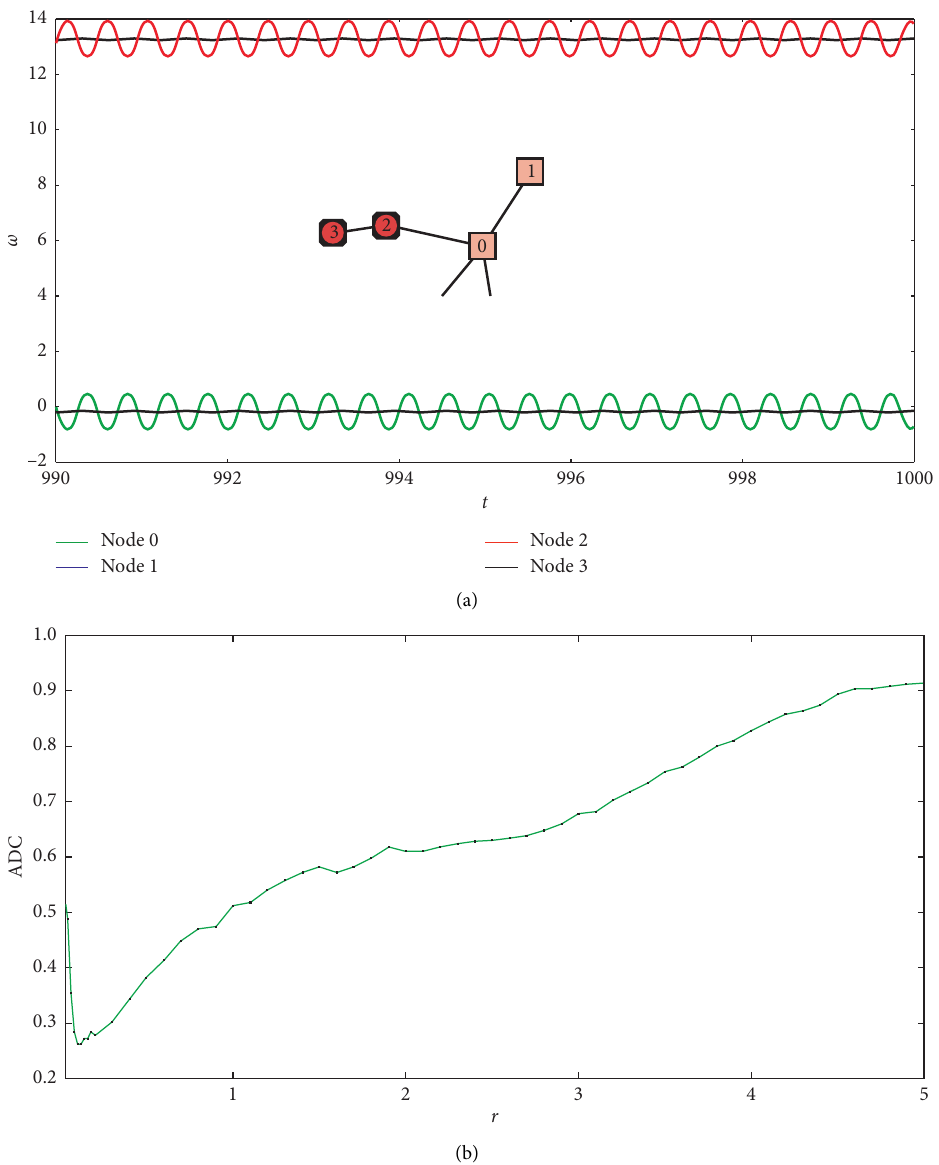
Figure 3: Stability of the CSG. (a) Time series of the snippet from the China Southern Power Grid with a one-time artificial perturbation located at node 0. In the stationary state, nodes 2 and 3 are driven periodically away from the synchronous state, while nodes 0 and 1 remain close to the state. (b) System antidisturbance capability ADC with respect to the synchronization rate r . Parameters are as follows: K P � 50, T � 20, T � 0 . 5, b � 3, c � 1, b � 5, c � − 1, f � 1, M � 2 . 0 , α � 0 . 1, K � 8, τ l D g g d d N commercial loads τ d � 5 . 0, and industrial loads τ d � 8 . 0, with varying the reaction rate of generators and therefore r � 1/ τ